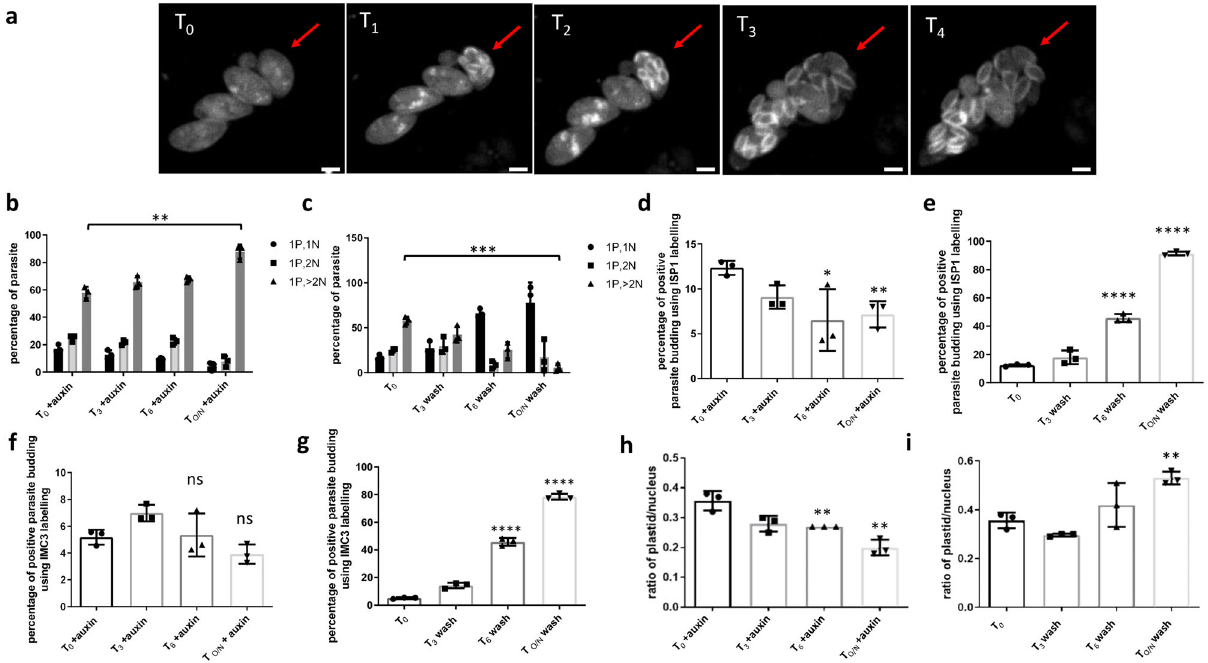
Fig. 6 iKD TgAP2IX-5 parasites treated with auxin resume cell division and daughter parasite formation mimicking endopolyogeny. a Video- microscopy images of iKD TgAP2IX-5 parasites at different timepoints after auxin washout. The budding vacuole and the emergence of parasites is indicated with a red arrow. The IMC of the parasite is labelled with IMC3-mCherry. The scale bar is indicated at the bottom right of each panel. b Bar graph representing nucleus per parasite ratio. Timepoint T 0 = 0 min is equal to start of auxin wash. Two-tailed p -values: ** p = 0.0015; mean ± s.d. ( n = 3 independent experiments). c Bar graph representing iKD TgAP2IX-5 nucleus per parasite counts during different timepoints of auxin washout treatments; 3 h, 6 h, and overnight (O/N) washout. Two-tailed p -values: ** p = 0.0001; mean ± s.d. ( n = 3 independent experiments). d Bar graph representing parasite budding in the iKD TgAP2IX-5 strain during overnight auxin treatment using ISP1 labelling. Two-tailed p -values: * p = 0.0457, ** p = 0.0057; mean ± s.d. ( n = 3 independent experiments). e Bar graph representing parasite budding in the iKD TgAP2IX-5 strain using TgISP1 labelling during different timepoints of auxin washout treatments; 3 h, 6 h, and overnight (O/N) washout. Two-tailed p -values: **** p < 0.0001; mean ± s.d. ( n = 3 independent experiments). f Bar graph representing parasite budding in the iKD TgAP2IX-5 strain using TgIMC3 labelling during overnight auxin treatment. Two-tailed p -values: ns: p > 0.05; mean ± s.d. ( n = 3 independent experiments). g Bar graph representing parasite budding in the iKD TgAP2IX-5 strain using TgIMC3 labelling during different timepoints of auxin washout treatments; 3 h, 6 h, and overnight (O/N) washout. Two-tailed p -values: **** p < 0.0001; mean ± s.d. ( n = 3 independent experiments). h Bar graph representing the ratio of plastid to nucleus in the iKD TgAP2IX-5 strain during overnight auxin treatment. Two-tailed p -values: ** p = 0.0029 (T O/N + auxin compared to T 0 ), ** p = 0.0095 (T 6 + auxin compared to T 0 ); mean ± s.d. ( n = 3 independent experiments). (i) Bar graph representing the ratio of plastid to nucleus in the iKD TgAP2IX-5 strain during different timepoints of auxin washout treatments; 3 h, 6 h, and overnight (O/N) washout. Two-tailed p -values: ** p = 0.0020; mean ± s.d. ( n = 3 independent